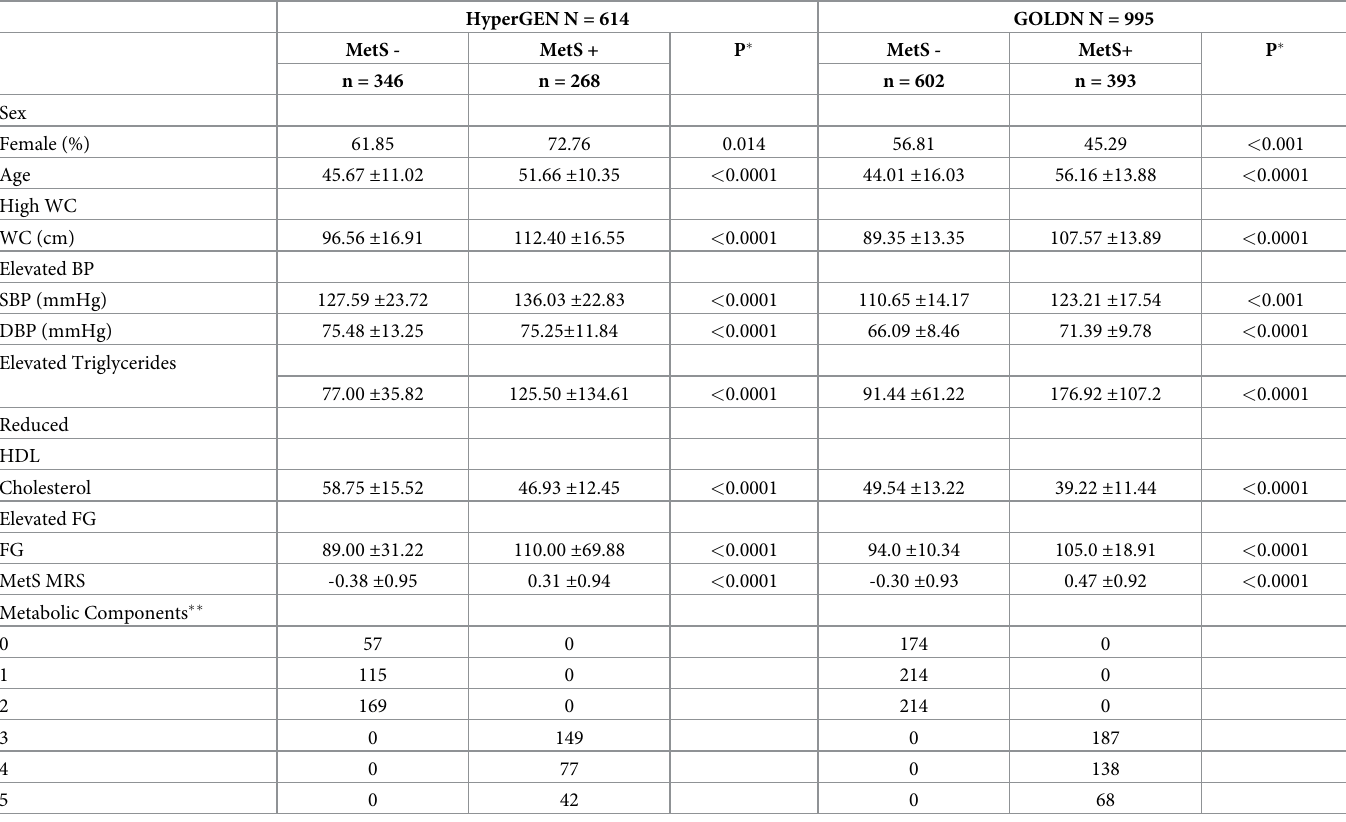
Table 2. Baseline characteristics of HyperGEN and GOLDN study